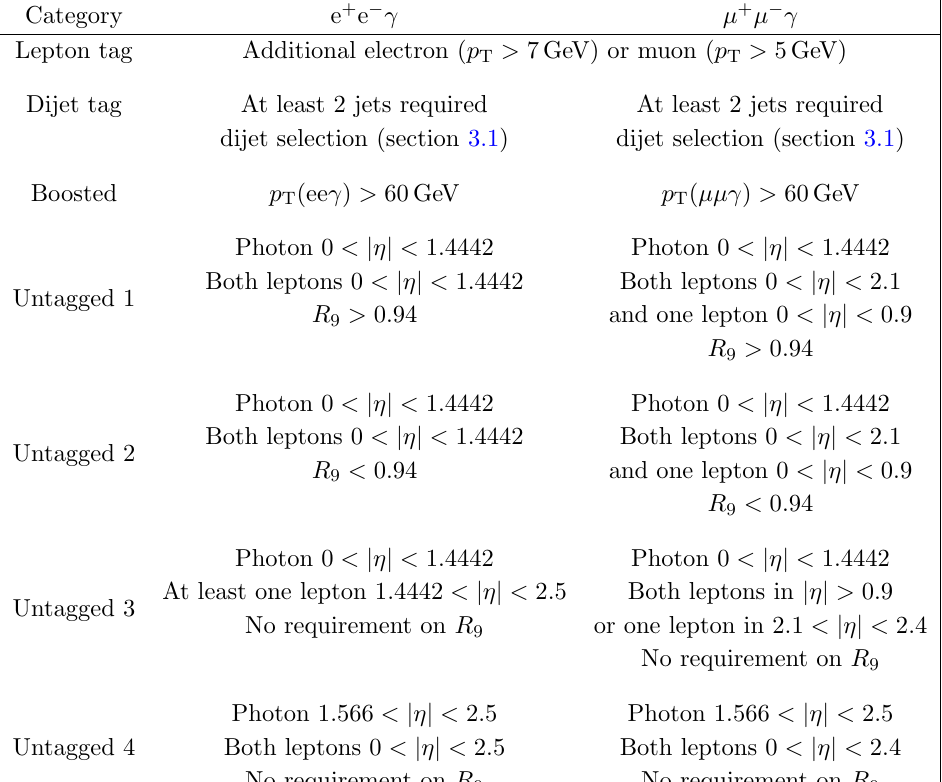
Table 1 . Categories in H separately in all classes except for the lepton-tag